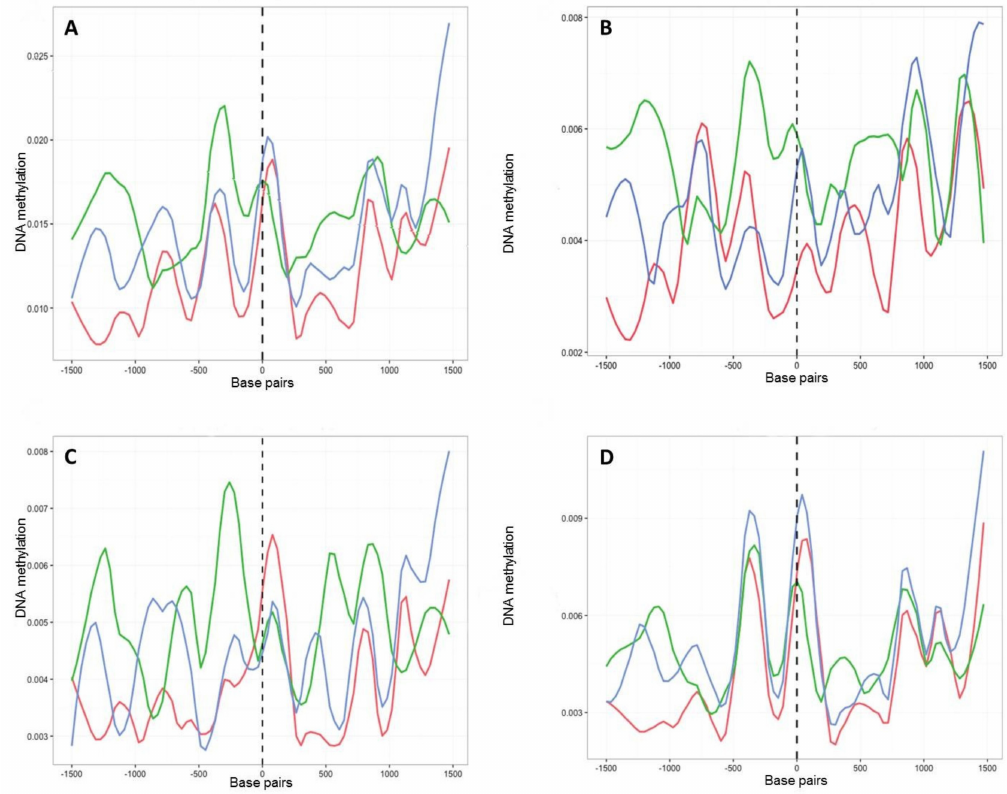
Figure 5. Methylation density across transcription start sites (TSSs) found in 131 genes associated with polysaccharide degradation in B. cinerea (27). Methylation level (vertical axis) at each time point (T1, red; T8, green; T8P, blue) was identified as the proportion of methylated cytosines against all cytosines in 30 bp windows 1.5 kb before and after the transcription start site (TSS) (horizontal axis). ( A ) Methylation level for all mCs; ( B ) methylation level for CpG context; ( C ) methylation level for CpHpG context; and ( D ) methylation level for CpHpH